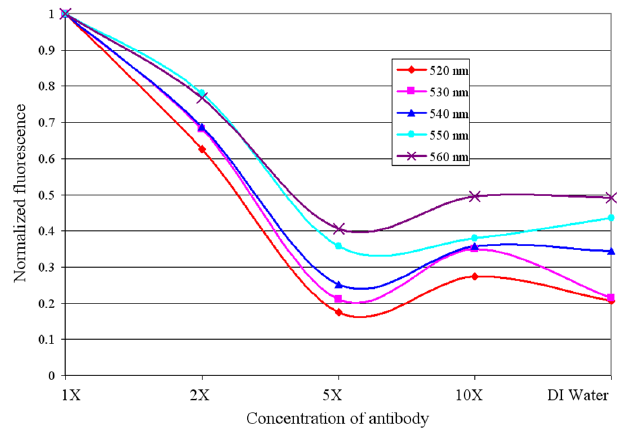
Figure 12. Comparison of normalized fluorescence for different concentration of antibody at various wavelengths.